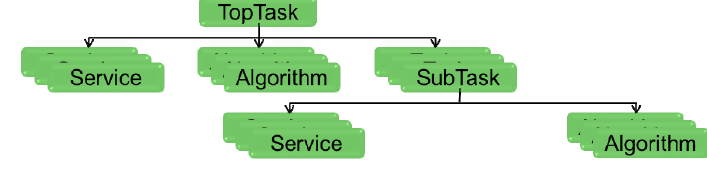
Fig.2. Components in SNiPER framework.